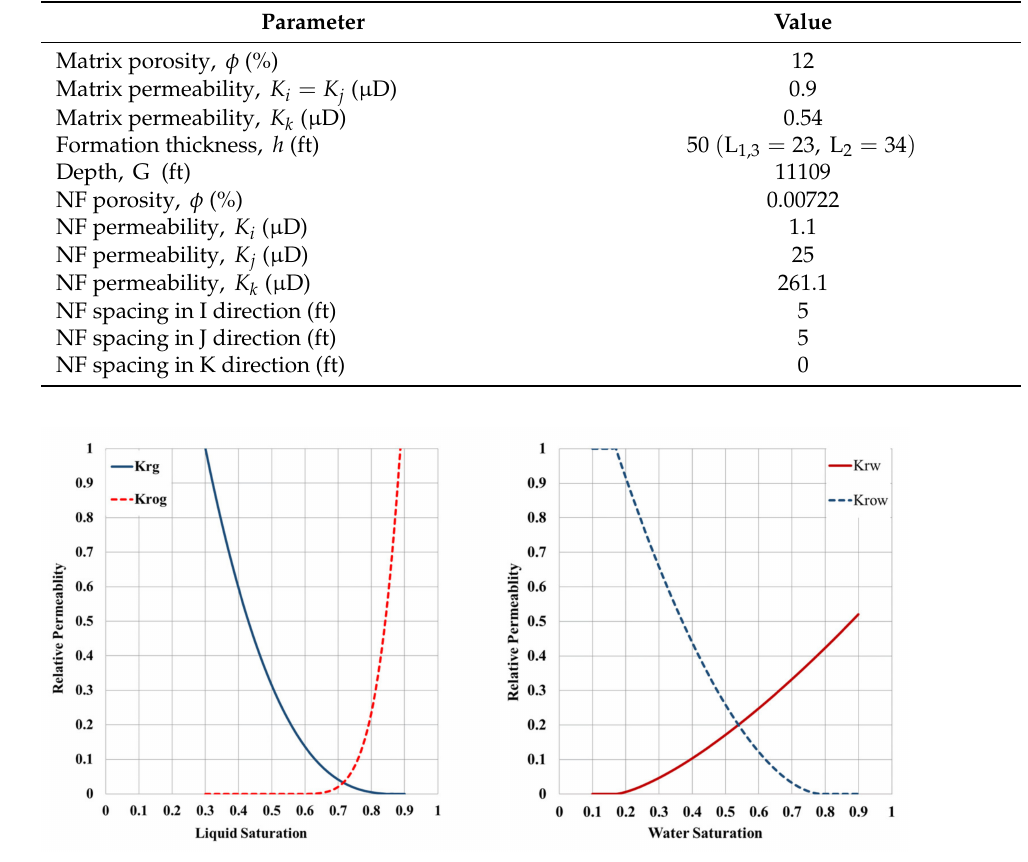
Figure 2. Relative permeability curves, Reprint with permission [23], 2019,